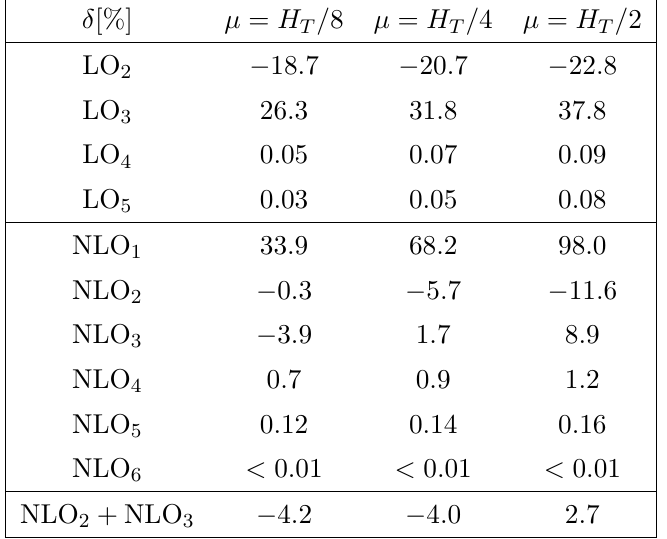
Table 8 . t (cid:22) tt (cid:22) t : (cid:27) =(cid:27) LO ratios at 100 TeV, for di(cid:11)erent values of (cid:22) = (cid:22) r = (cid:22) f . (N)LO i QCD proportional to y 4 are present in all the (N)LO with i (cid:21) 3, but also terms proportional t i